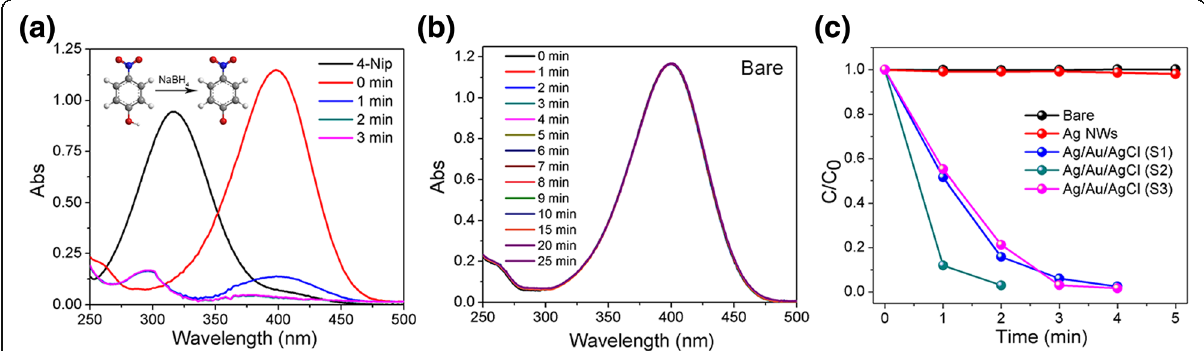
Fig. 6 a UV-vis spectral changes of Nip by using 0.025 mg of S2 as catalyst. b Time-dependent UV-vis spectrum of Nip without any catalysts. c Normalized concentration change of Nip in the presence of 0.025 mg as-prepared